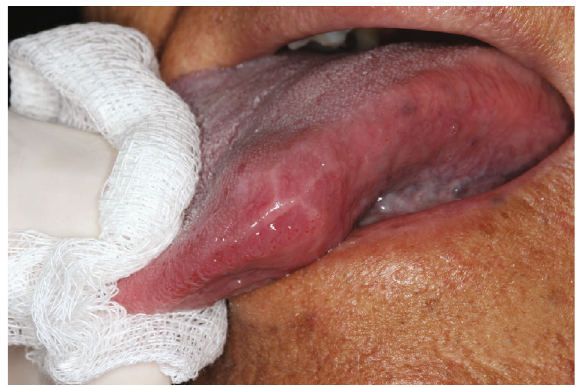
Figure 1: Presence of a free, well-de fi ned, rounded nodule, with the tongue showing normal color and an enlarged aspect in the central region on visual clinical examination.